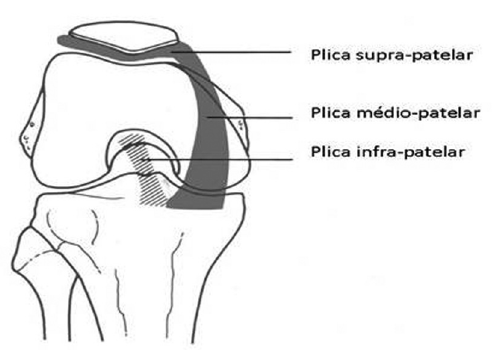
Figure 1 – Diagram of the three types of synovial